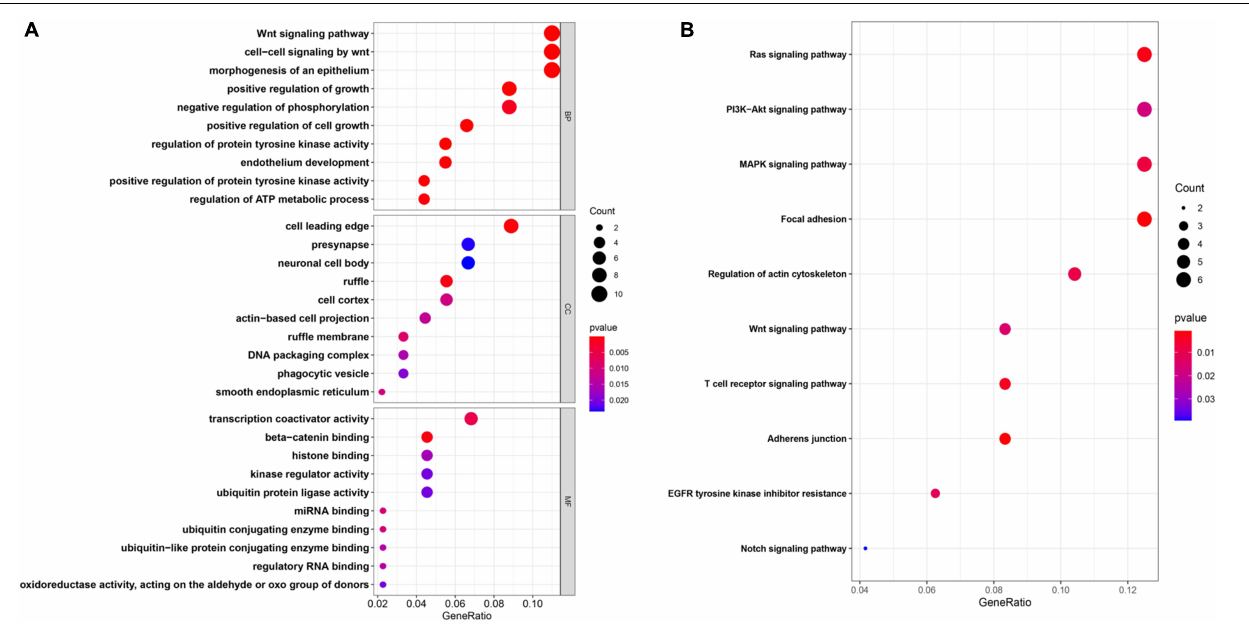
FIGURE 4 | (A,B) Enrichment of the top 10 Gene Ontology (GO) terms (A) and Kyoto Encyclopedia of Genes and Genomes (KEGG) pathways (B) of the differentially expressed mRNAs. The color of the dots changes gradually from blue to red in ascending order according to the adjusted P -values. The size of the node represents the number of